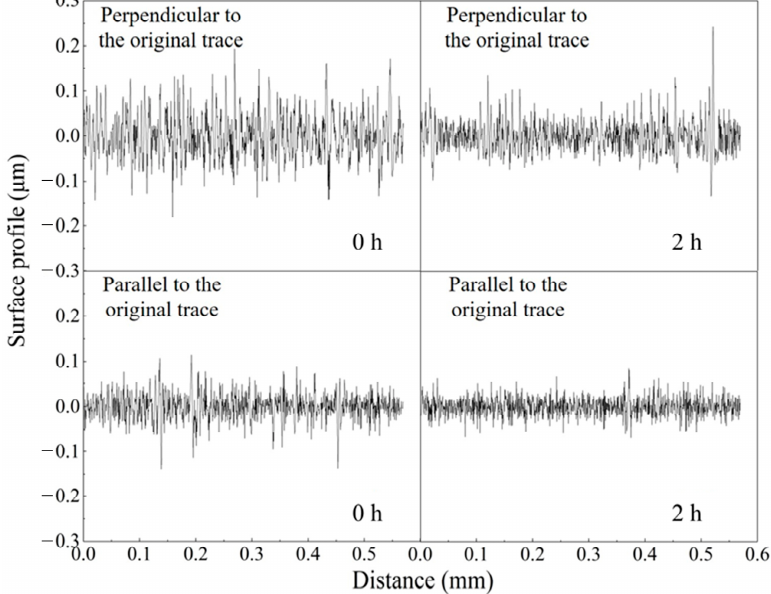
Figure 9. Surface profile curves of brass workpiece surface in parallel and vertical directions along the original marks before and after being polished with alumina-doped titanium dioxide ER polishing fluid (rotation speed = 200 r/min, voltage = 3 kV, machining gap = 0.5 mm).